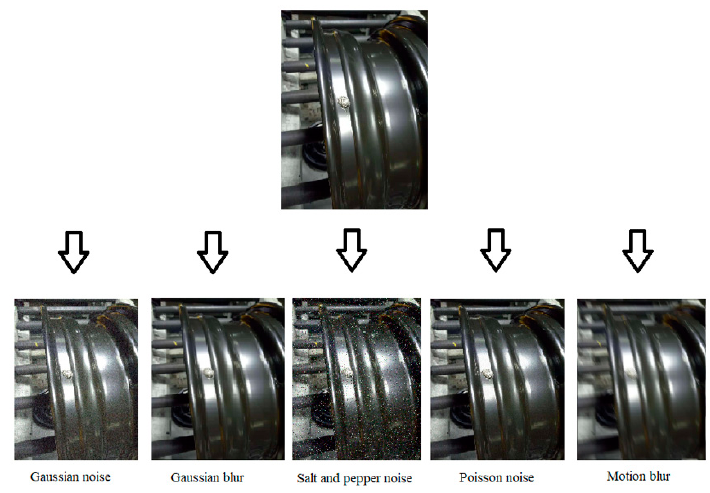
Figure 3. Augmentation of the images.